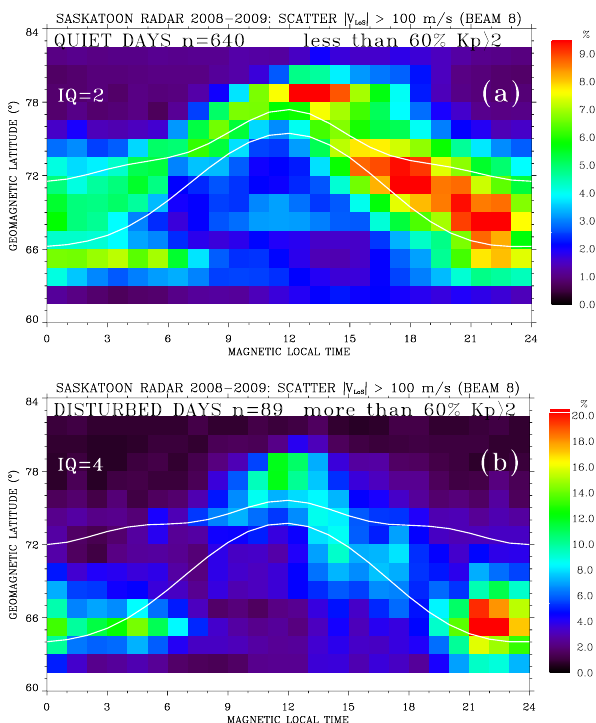
Fig. 9. The occurrence of E- and F-region ionospheric backscatter with absolute value of LoS velocity exceeding 100ms − 1 observed by the Saskatoon radar beam 8 during geomagnetically (a) quiet and (b) moderately disturbed